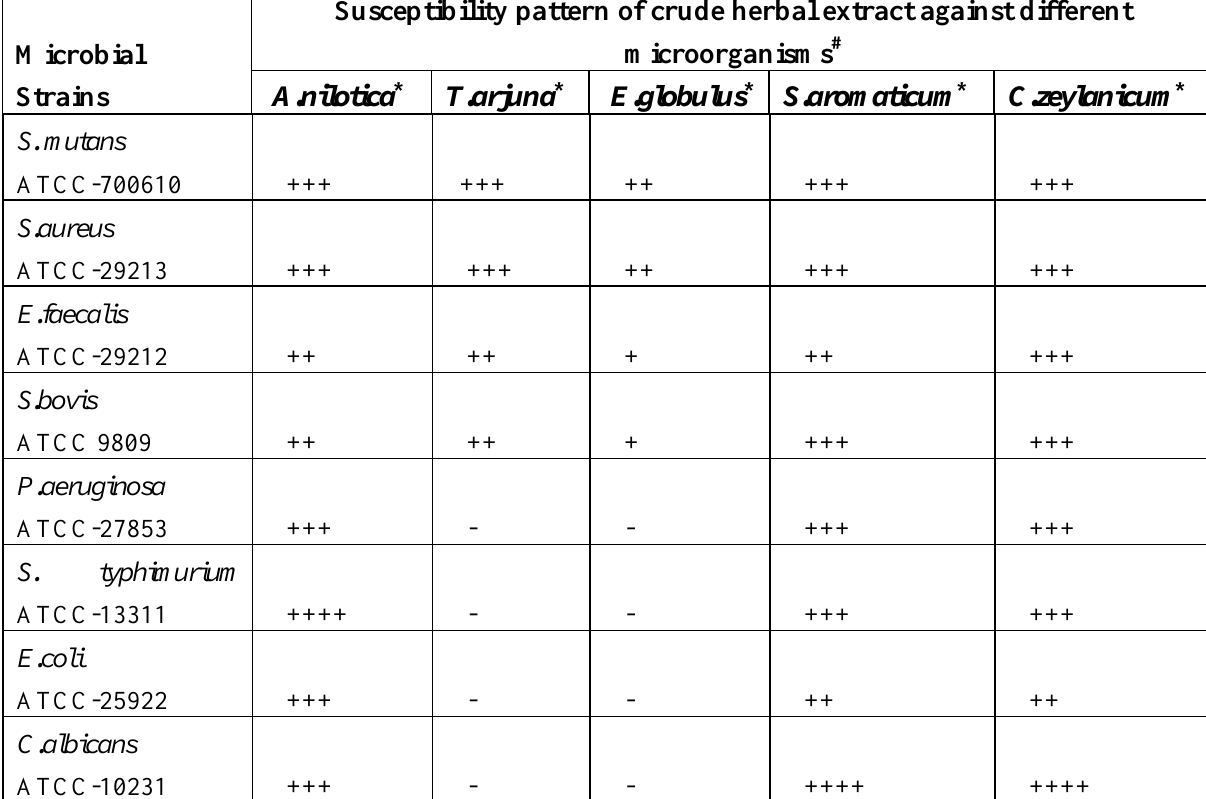
Table 1. Susceptibility pattern of crude ethanolic herbal extracts against different microorganisms.